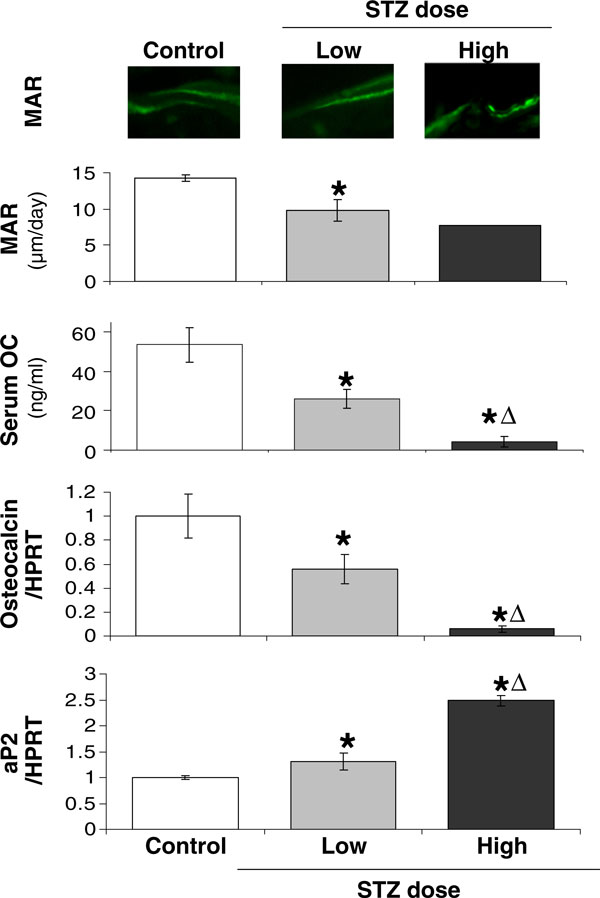
STZ-induced T1-diabetes decreases MAR, serum osteocalcin, and bone osteocalcin mRNA while increasing aP2 expression. Control (white bar), 40 mg/kg STZ (low dose, gray bar), and 60 mg/kg STZ mice (high dose, black bar) were examined at 19 dpi for osteoblast parameters: mineral apposition rate (MAR; representative fluorescent images of calcein labeling of bone shown at top of figure), serum osteocalcin (OC), and tibial osteocalcin mRNA levels [expressed relative to hypoxanthine–guanine phosphoribosyl transferase (HPRT), a housekeeping gene). Expression of a mature adipocyte marker, aP2, was also examined. For all RNA analyses, expression was expressed relative to control levels which were set to 1. Values represent the average ± SE. n > 3 per condition, except for high STZ dose MAR (n = 1). *p < 0.05 compared to control; Δp < 0.05 compared to 40-mg/kg STZ dose.